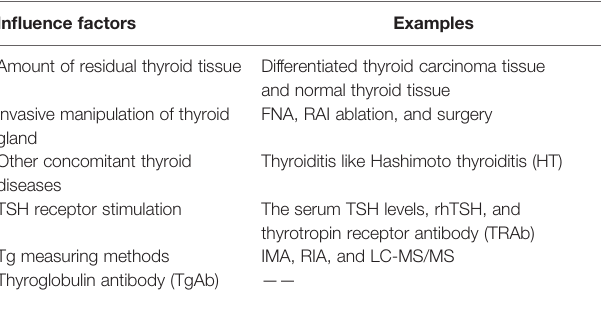
TABLE 2 | Factors in fl uencing serum thyroglobulin levels in patients with differentiated thyroid